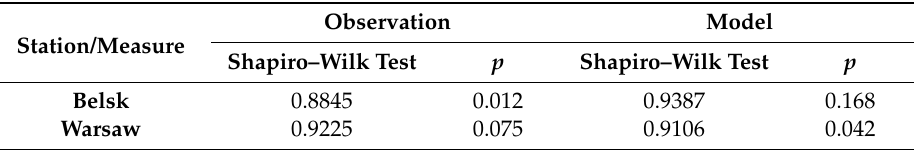
Table 4. Results of the Shapiro–Wilk test together with the right values of probability for Belsk and Warsaw stations for